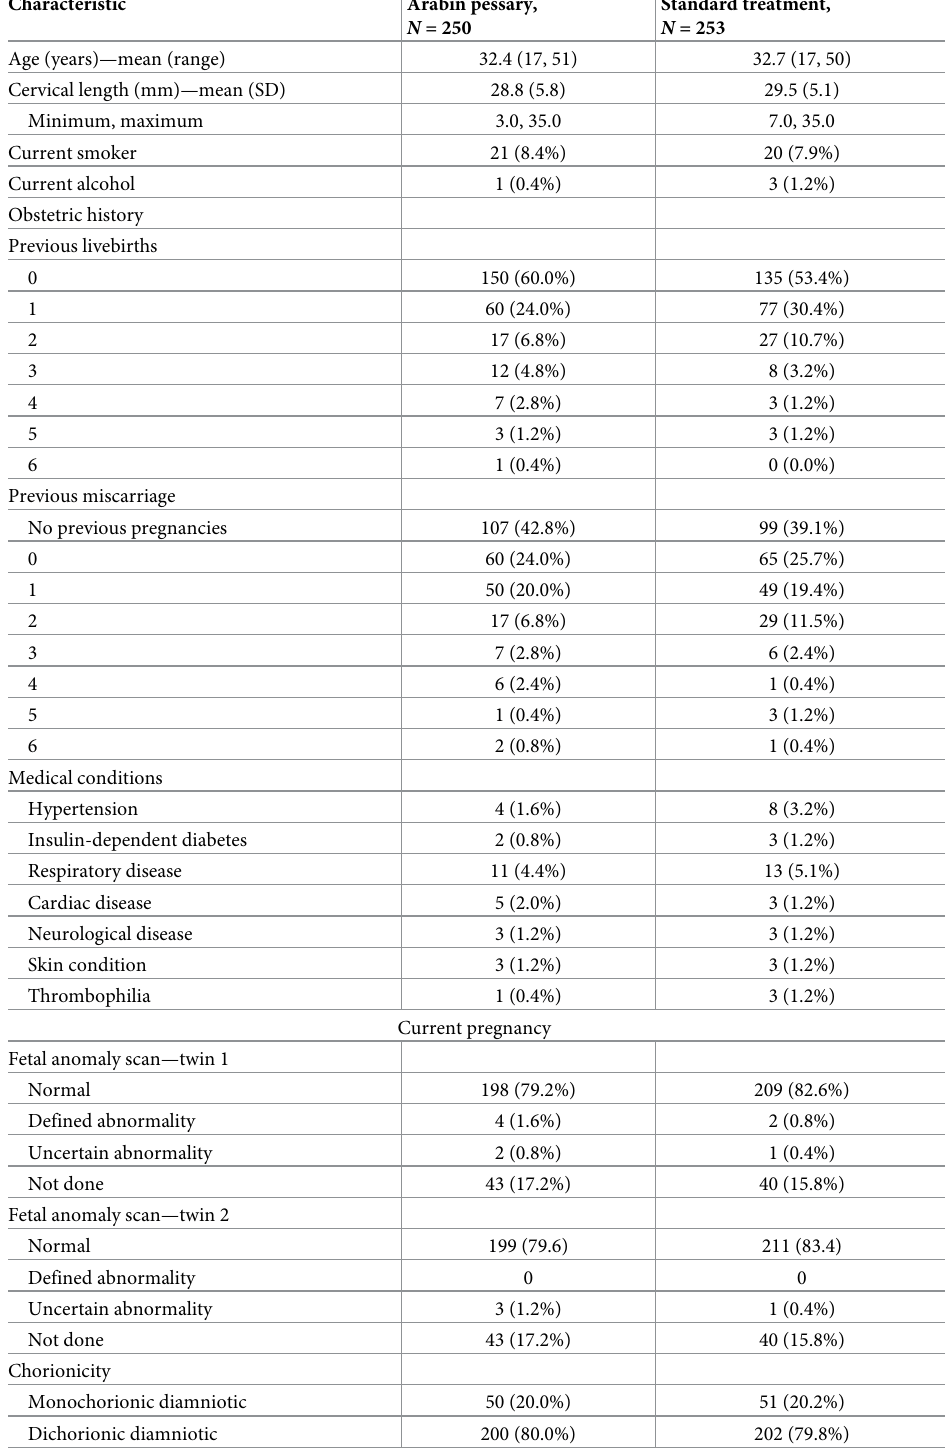
Table 1. Baseline characteristics of randomised